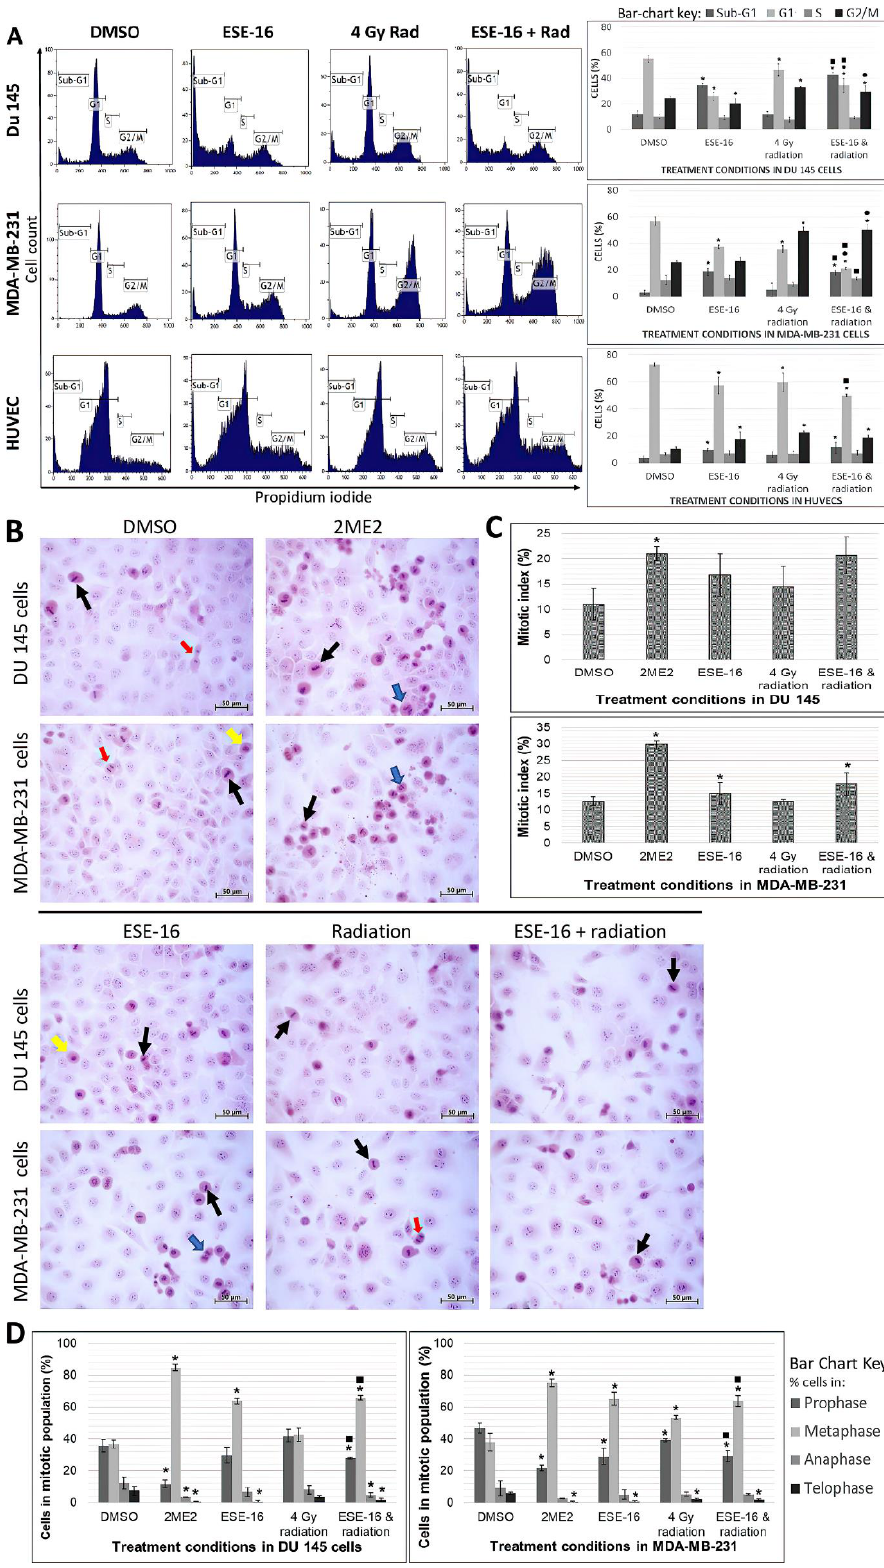
Figure 3. Cell cycle analysis and mitosis studies. ( A ) Flow cytometric histograms of cell cycle progression in DU 145-, MDA-MB-231 cells, and HUVECs exposed to ESE-16 and 4 Gy radiation. Cell count was plotted against PI (FL3). DMSO was used as the vehicle control. Higher sub-G 1 and G 2 /M populations were accompanied by lower G 1 populations. ( B )